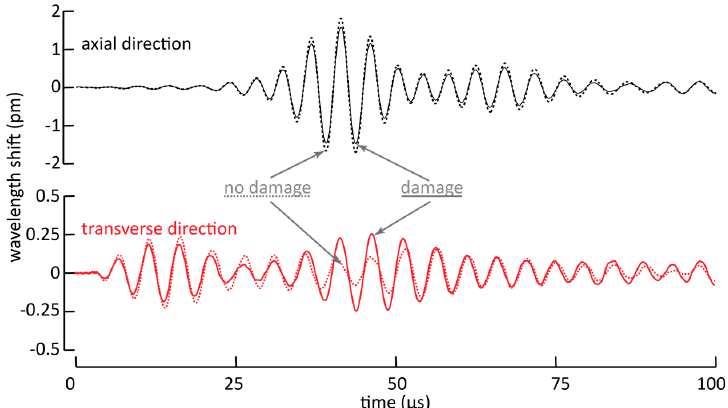
Figure 6. Wavelength shifts corresponding to axial and transverse strains for a pristine and damaged situation for the sample described in Section 3.1.